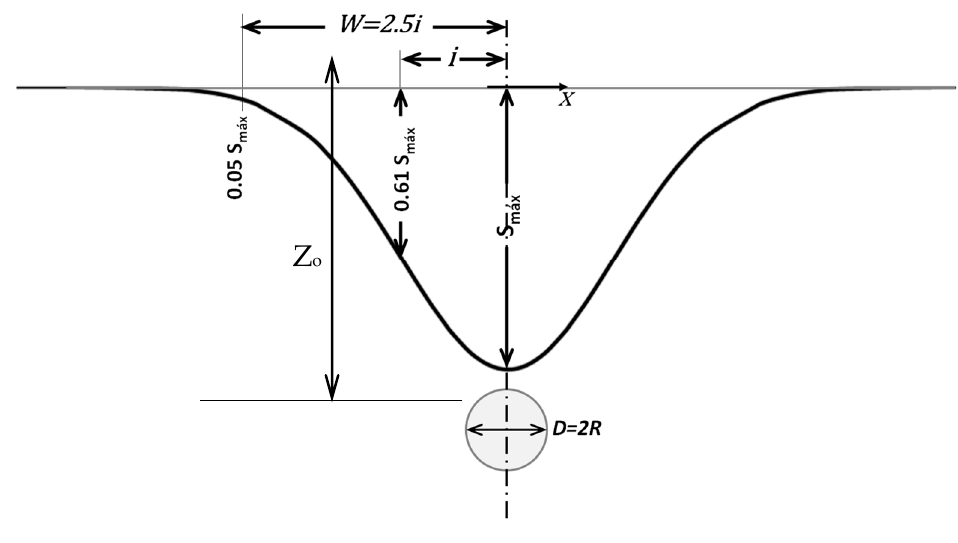
Figure 1. Settlement trough.